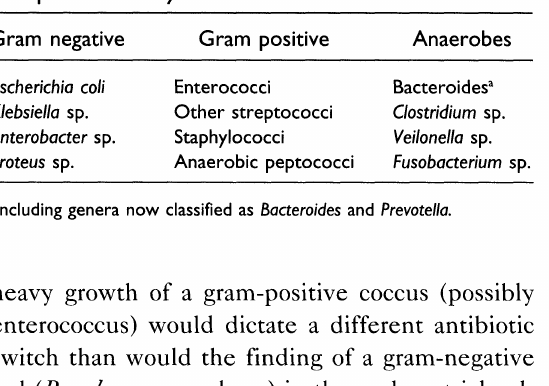
TABLE 3. Common bacterial isolates in cases of puerperal endomyometritis